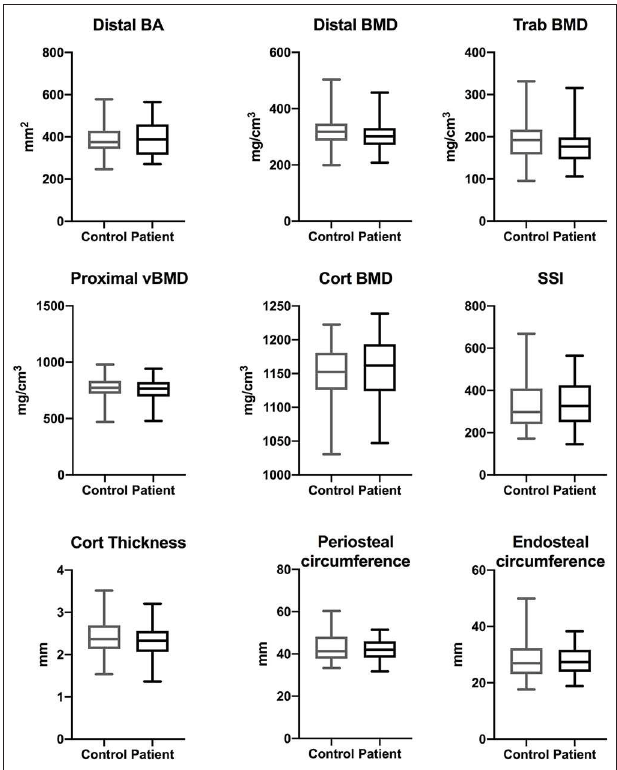
FIGURE 2 | Bone characteristics at radial site in adults with APECED ( n = 37) in comparison to age- and gender-matched control subjects ( n = 68). Total bone area (BA), total, cortical and trabecular volumetric bone mineral density (vBMD), strength-strain indices, and cortical dimensions measured at proximal (66%) and distal (4%) site of radius with pQCT.